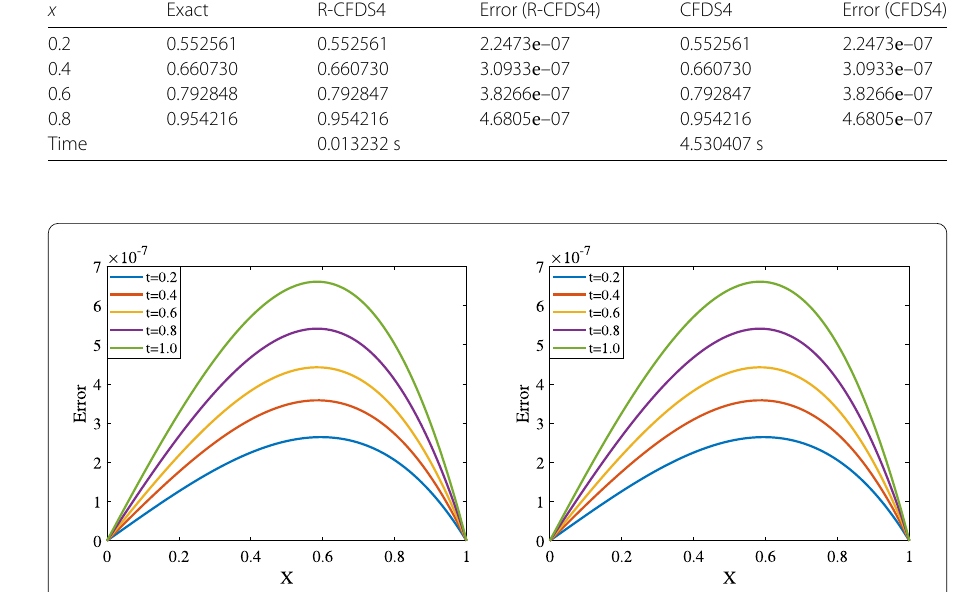
Figure 5 The errors of solutions of R-CFDS4(left) and CFDS4(right) with h = 0.02 and τ = 0.01 for SP